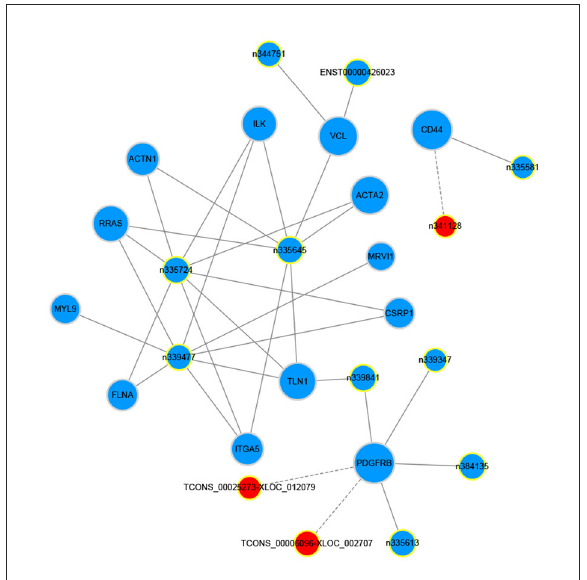
FIGURE8 Co-expression network of our concerned differentially expressed mRNAs and lncRNAs. The dots in the figure represent mRNAs, and the yellow circled dots represent lnRNAs (The red indicates up-regulated lncRNAs, and blue, down-regulated). The line represents the regulatory relationship between the two genes (Solid line represents positive regulation, and the dashed line represents negative regulation). The size of the circle represents the ability of a lncRNA/mRNA to interact with other genes, and this ability is quantified by degree. The greater the degree, the more genes that interact with this